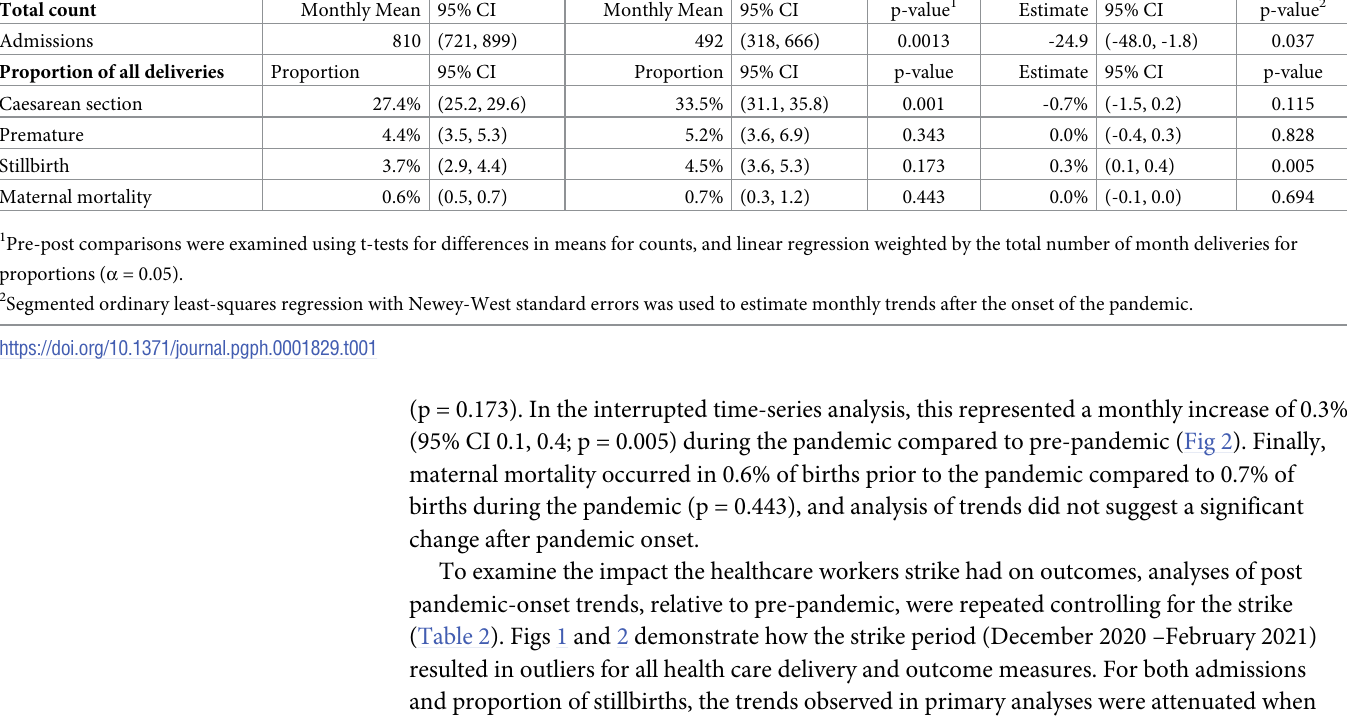
Table 1. Service delivery and adverse birth outcomes comparing the pre-pandemic (January 2019 –February 2020) and pandemic (March 2020 –March 2021) peri- ods, as well as the change in monthly trend post-pandemic onset. Outcome